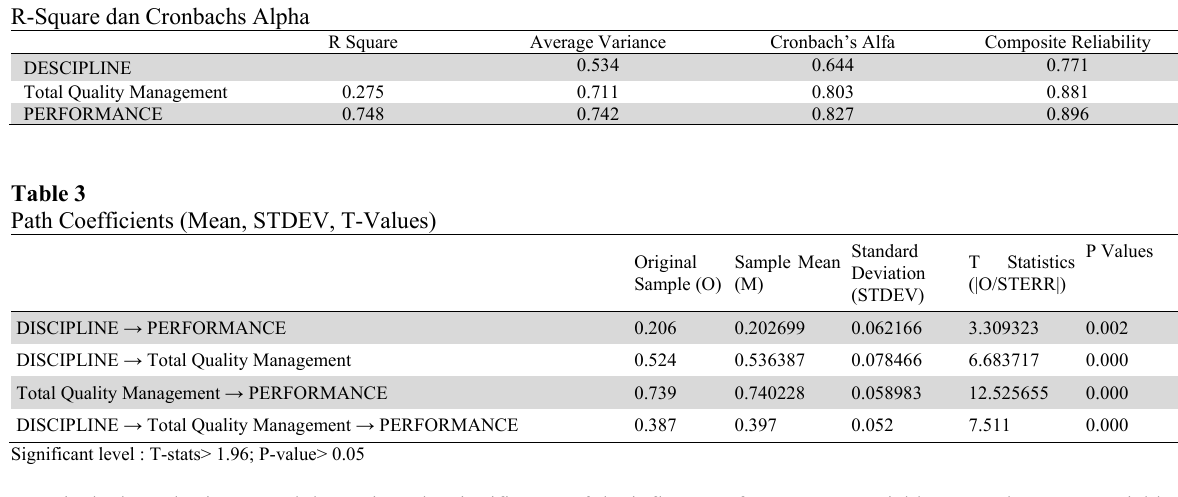
R-Square dan Cronbachs Alpha R Square Average Variance Cronbach’s Alfa Composite Reliability DESCIPLINE